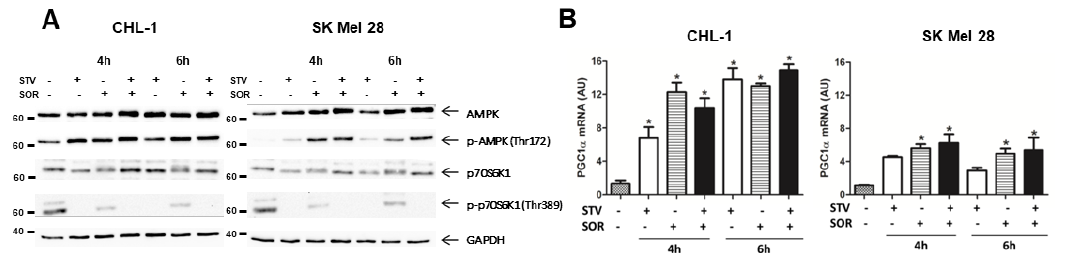
Figure 4. Combined exposure to sorafenib and starvation stimulates biogenesis in human melanoma cells. ( A ) The activity of the AMPK and mTOR signaling pathways were evaluated by measuring the phosphorylation status of AMPK (p-AMPK on Thr172) or the mTOR target p70S6K1 (p-p70S6K1 on Thr389) in CHL-1 and SK Mel 28 cells treated or untreated (4 or 6 h) as indicated, by western blotting analysis. Total AMPK, p70S6K1, and GAPDH were used as internal/loading controls ( n = 3). ( B ) The expression of PGC1α was evaluated by qRT-PCR in the same experimental condition described in A. (Histograms represent mean ± SD; n = 3) * p < 0.005 compared to control cells.